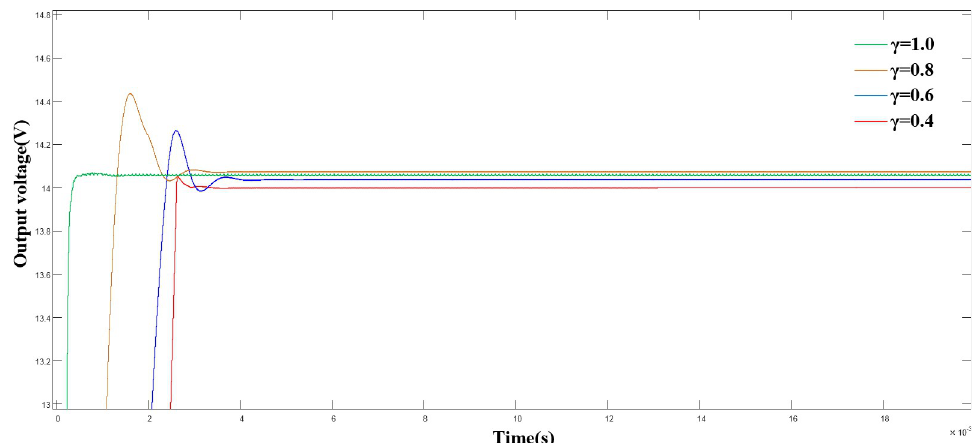
Fig 6. Comparison of output voltage under different γ values.